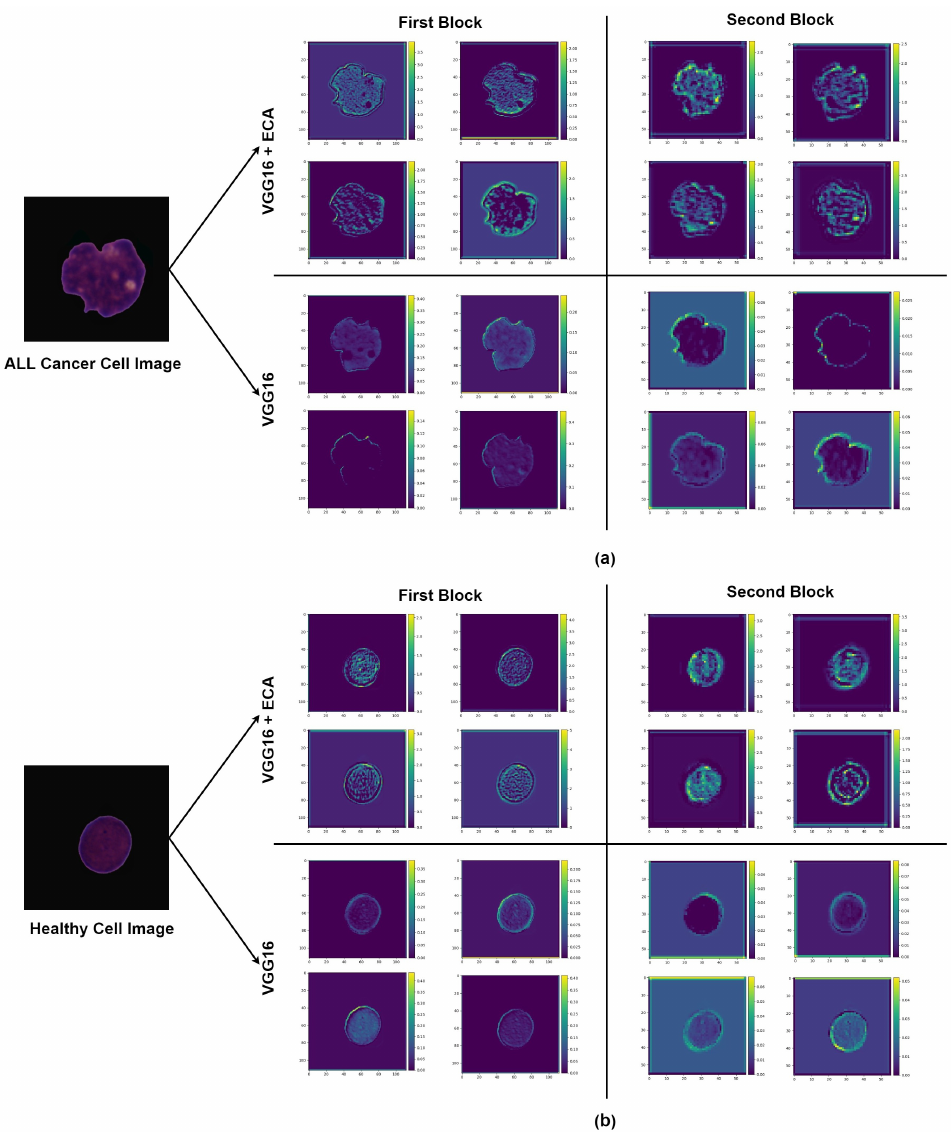
Figure 8. Feature maps generated by the first and second block of VGG16 with and without the ECA module. ( a ) The feature maps of ALL cancer cell image ( b ) the feature maps of healthy cell